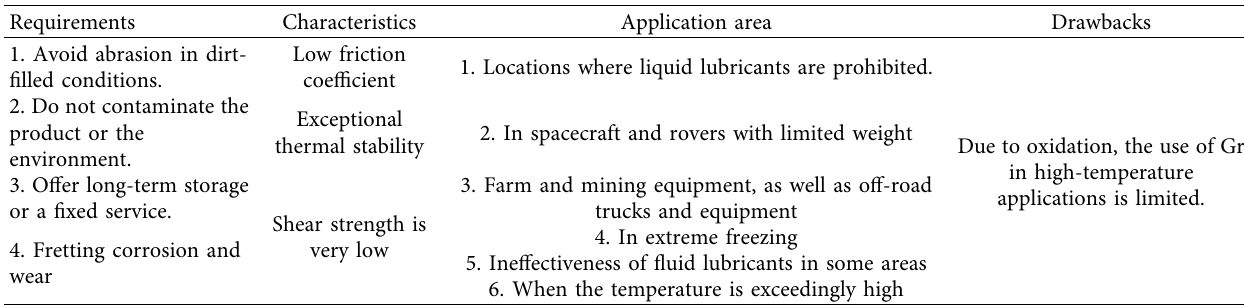
Table 5: Solid lubricants (Gr, MoS